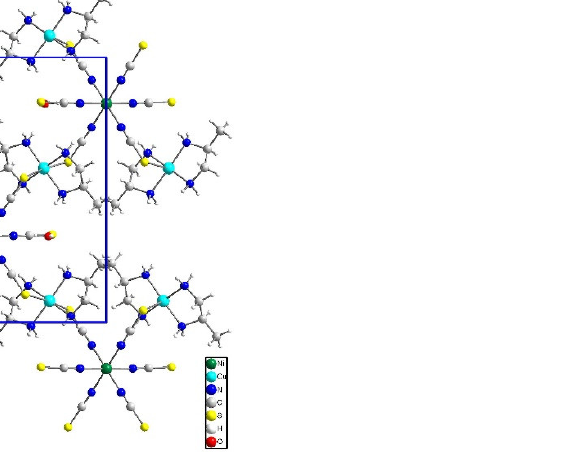
Figure 2. Structure of single ab layer along c axis in 1 . For clarity of the figure, minor population sets are omitted. are